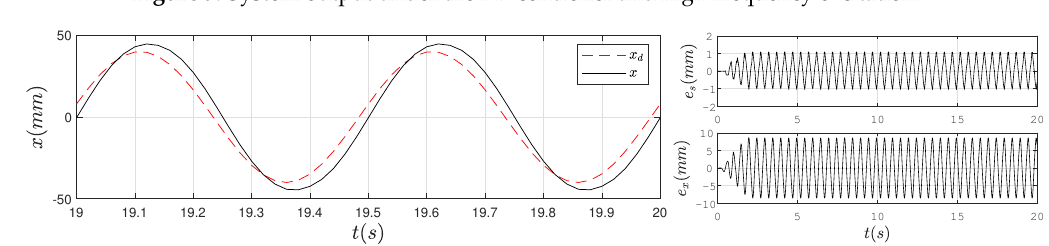
Figure 9. System output under the PD controller and high-frequency excitation.